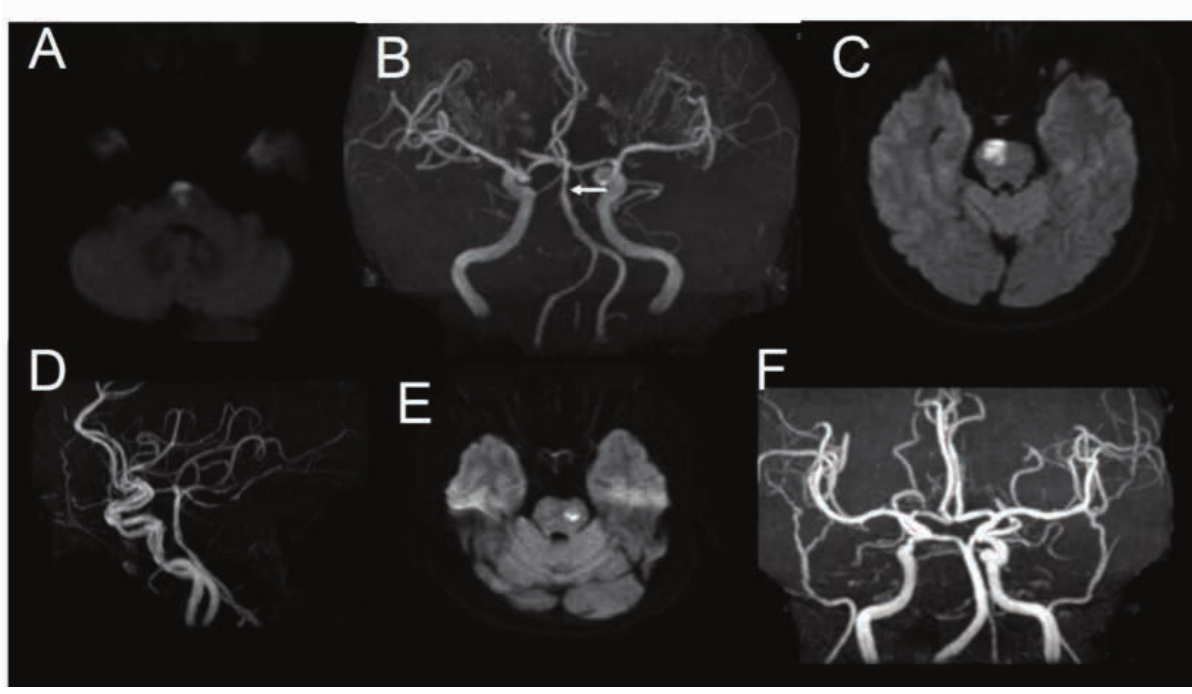
Figure 2: Paramedian pontine infarct (PPI) and lacunar pontine infarct (LPI) in brain imaging of DWI and MRA image. (A) Axial DWI showing a PPI. (B) MRA showing stenosis of the basilar artery of the same patient as A. (C) Axial DWI showing a PPI. (D) The basilar artery of the same patient as C is normal; (E) Axial DWI showing an LPI. (F) The basilar artery of the same patient as E is